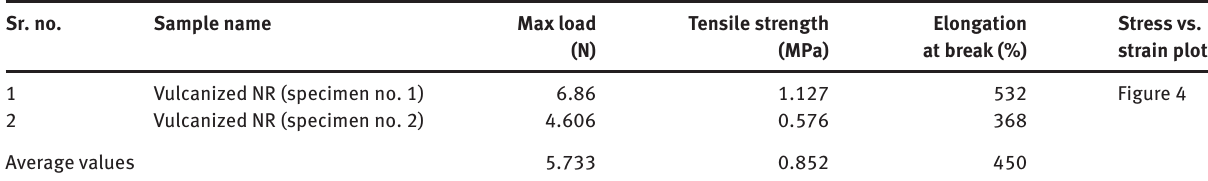
Table 2: Initial properties of vulcanized NR. Sr. no.